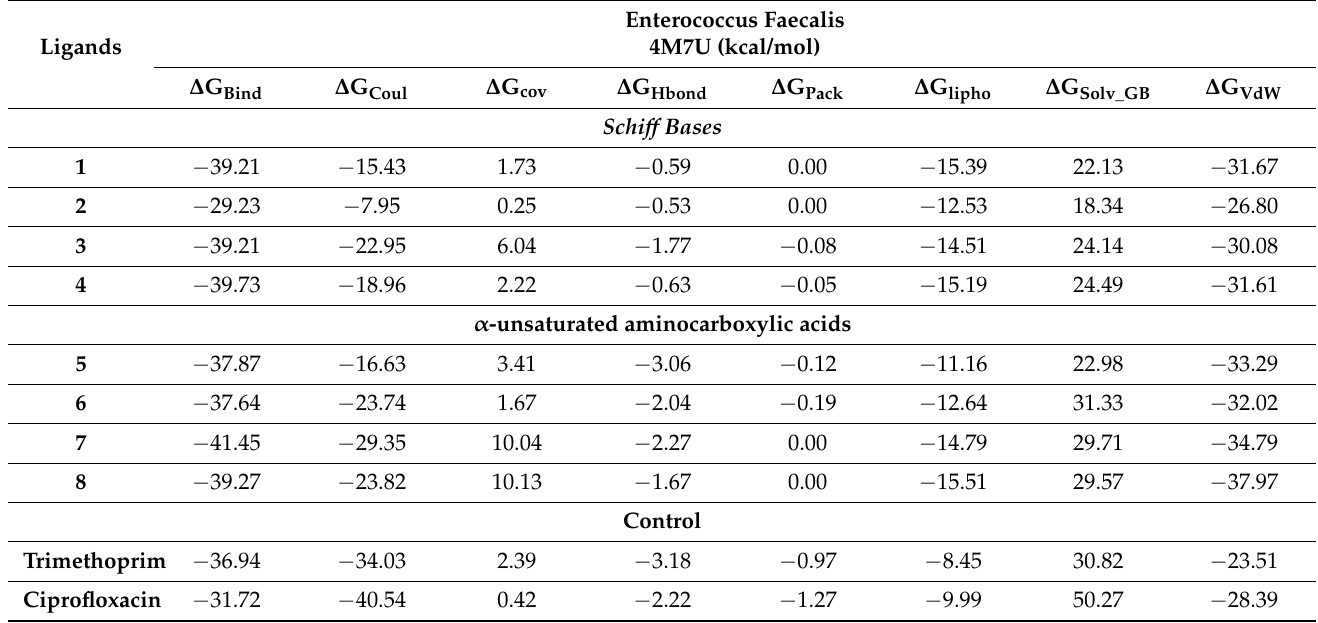
Table 7. Binding free energy components for 4M7U-ligand complexes calculated by MM-GBSA analysis.